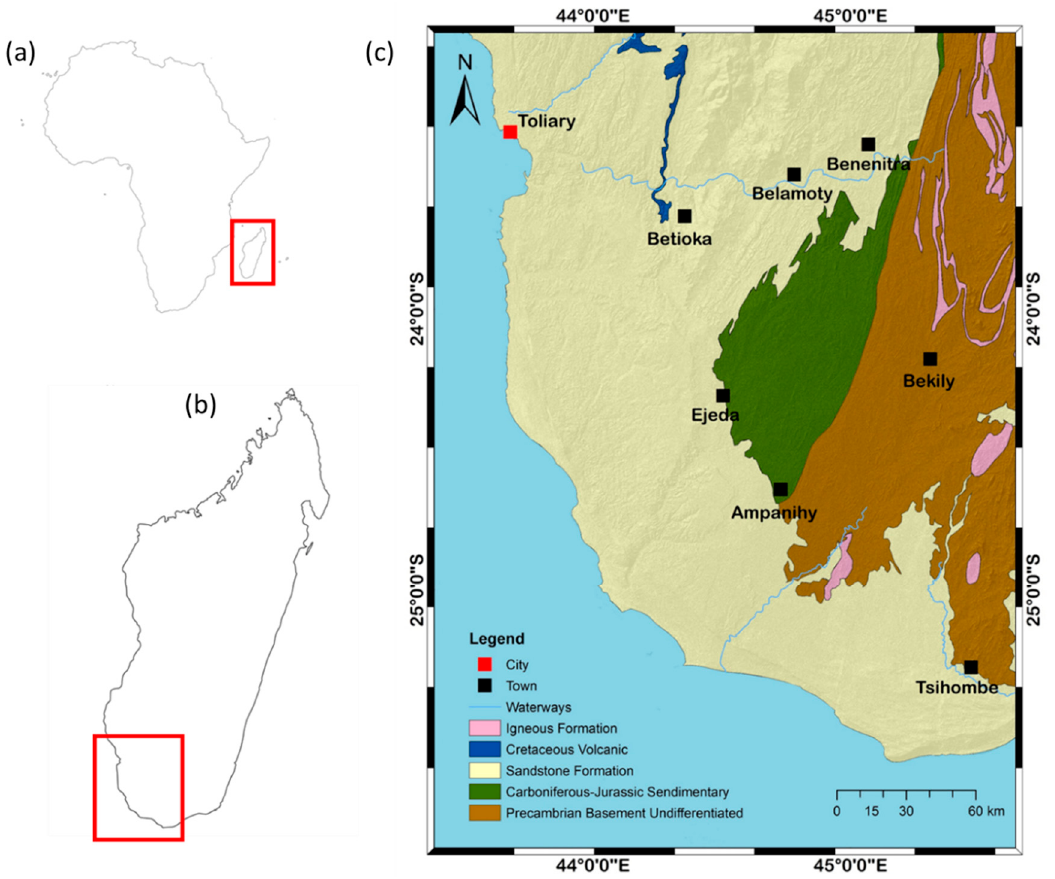
Figure 2. ( a ) Location of Madagascar within the African continent; ( b ) Location of the study area in Madagascar; and ( c ) simplified geology of the great south-west part of Madagascar (source: Bureau de Recherches G é ologiques et Mini è res